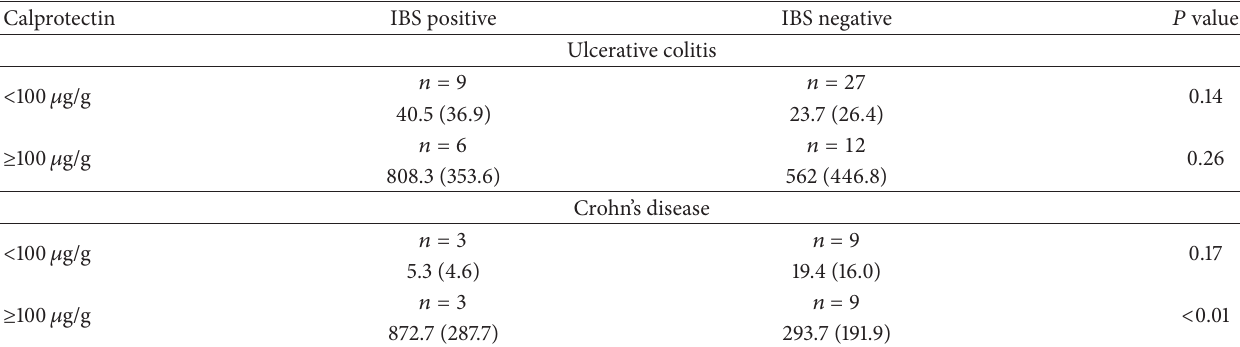
Table 2: Mean (SD) levels of calprotectin in IBD patients with or without IBS-like symptoms using a cutoff of < 100 𝜇 g/g. Calprotectin IBS